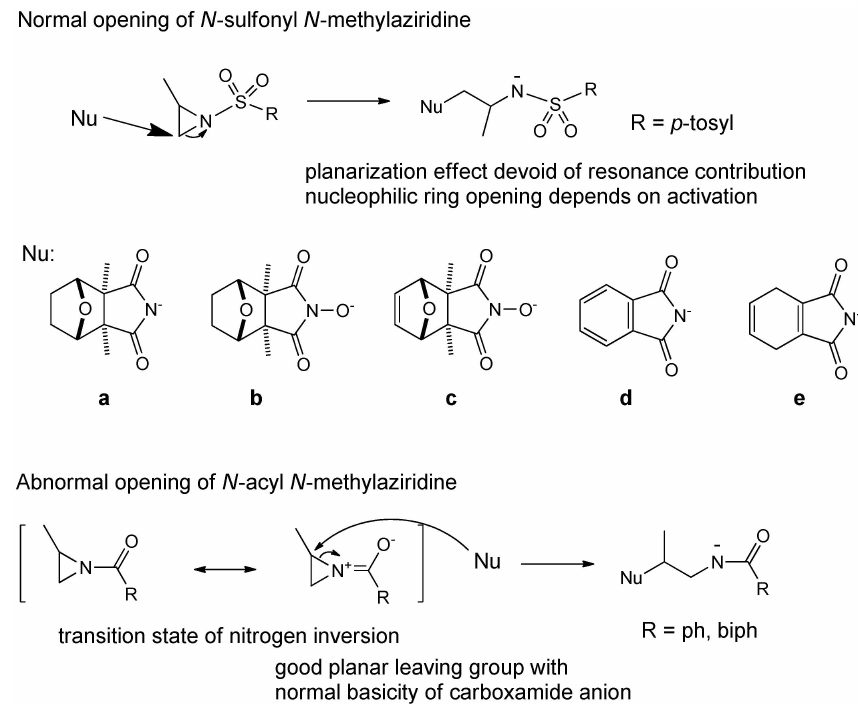
Figure 2. Regioselectivity in nucleophilic ring opening of N -sulfony and N -acyl activated 2-methylaziridine.